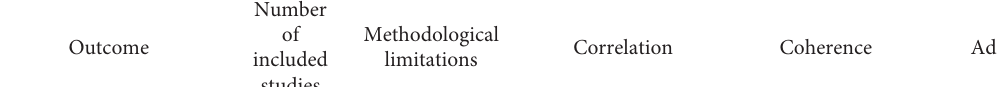
Table 6: Evidence of the qualitative analysis using CERQual